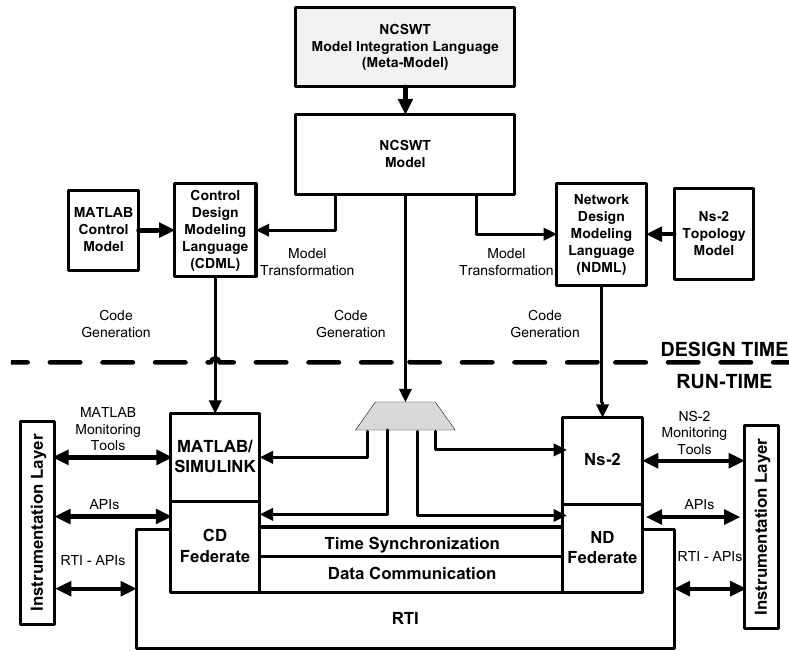
Figure 2. NCSWT tool chain